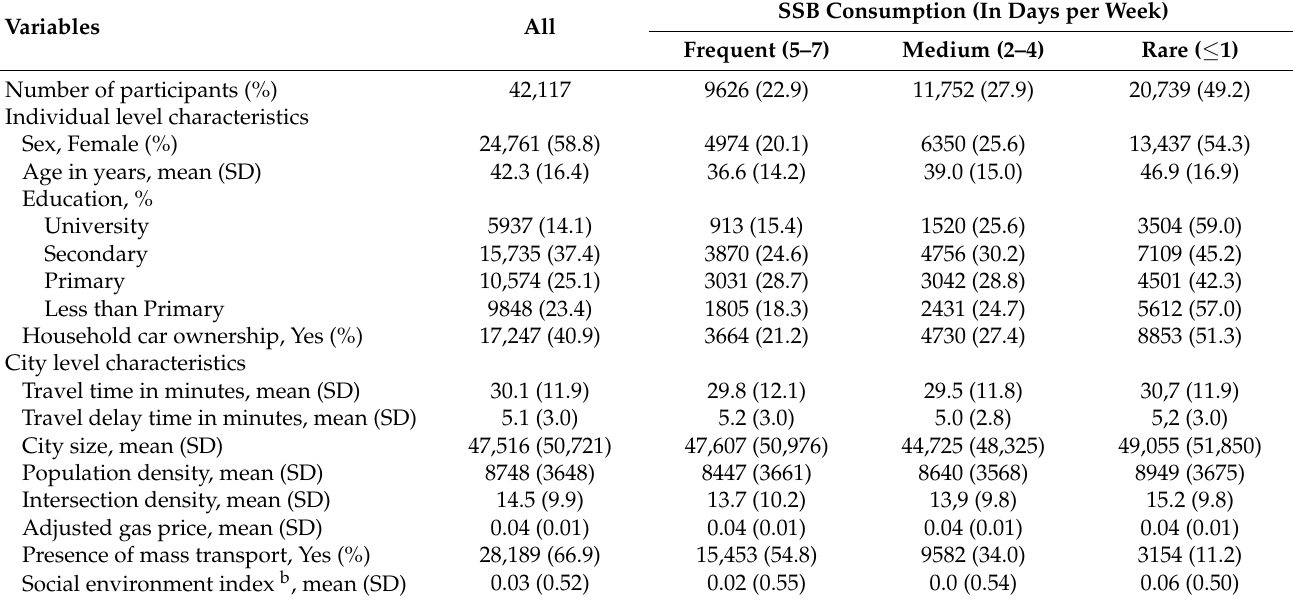
Table 2. Characteristics of the sample a , overall and by sugar-sweetened beverages (SSBs) consump- tion